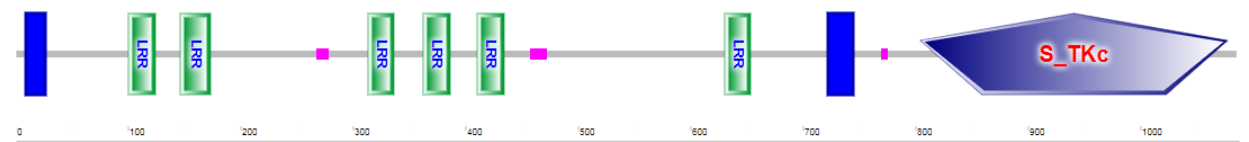
Figure 2. Relative expression levels of BAK1 . *** indicate significant differences ( p < 0.05, respectively). BTC: ‘Bingtang’ sweet orange; STY: Pomelo; NCXY: Nanchuan citron; YSJY: Wild citron; YXY: Round citron; MGJY: American citron; FS: Finger citron; JY C-05: Citron C-05.